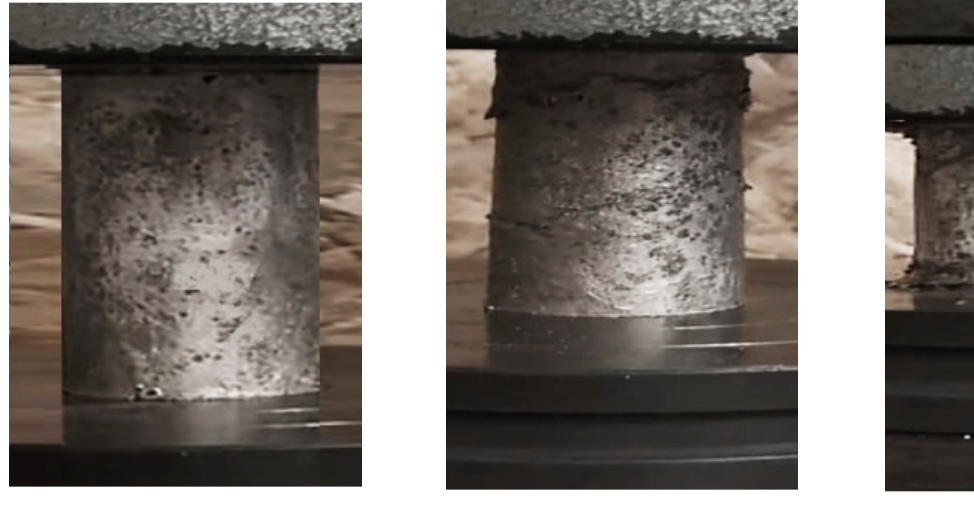
Figure 6. The sample H4 under compression load.